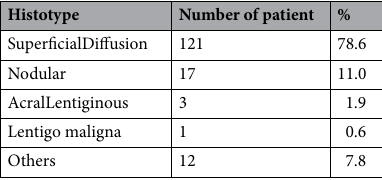
Table 2. Histotype’s distribution.